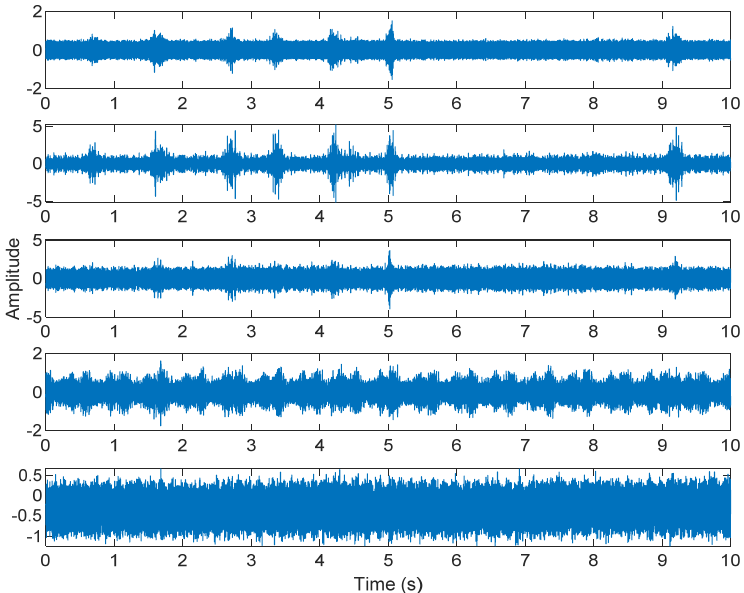
Figure 25. Analysis of data separated by ICA-VMD.